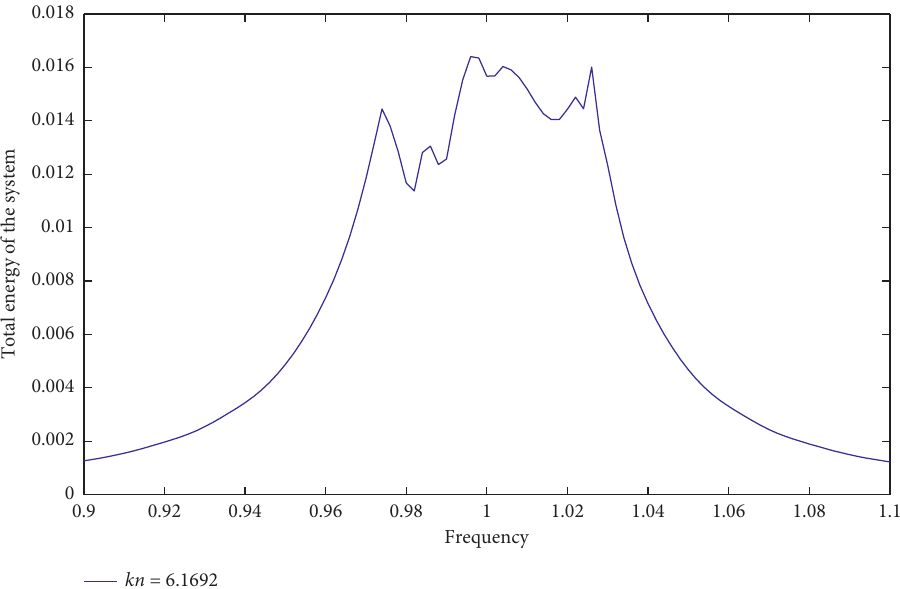
Figure 23: Average total energy of the system with respect to excitation frequency ( kn � kn